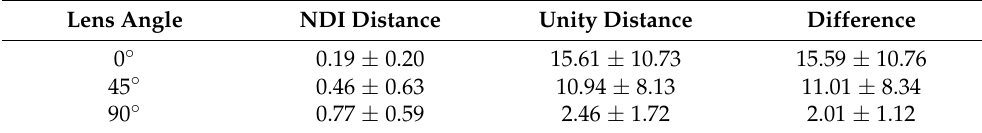
Table 2. Mean and standard deviation of distance error (mm).